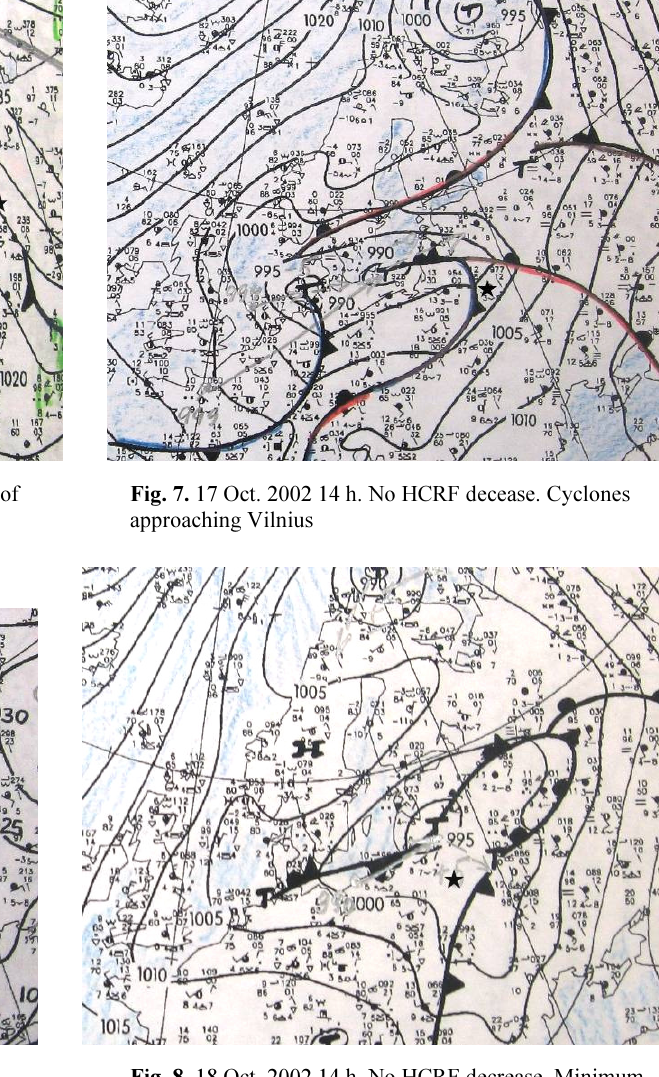
Fig. 5. 15 Oct. 2002 14 h. No HCRF decrease. Fig. 8. 18 Oct. 2002 14 h. No HCRF decrease. Minimum Cyclone motion eastward in Vilnius direction atmospheric pressure formation (997 hPa) in Vilnius in six days after the first registration of HCRF decrease (Fig. 2)